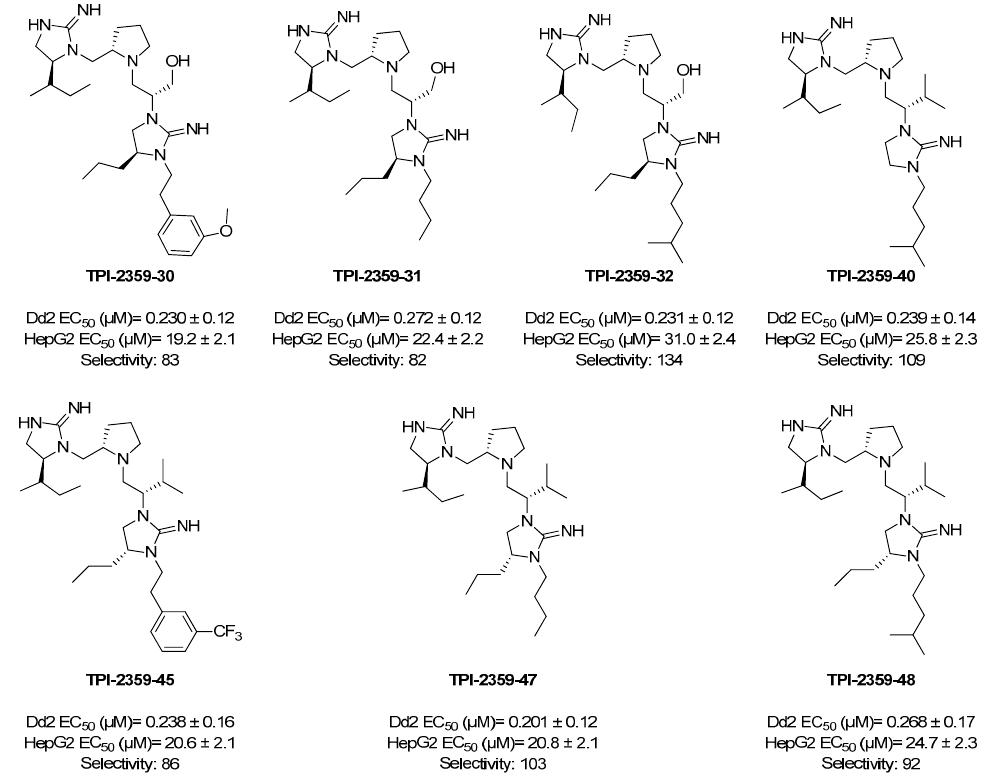
Figure 4. Structures and activity of identified top antiplasmodial hits.